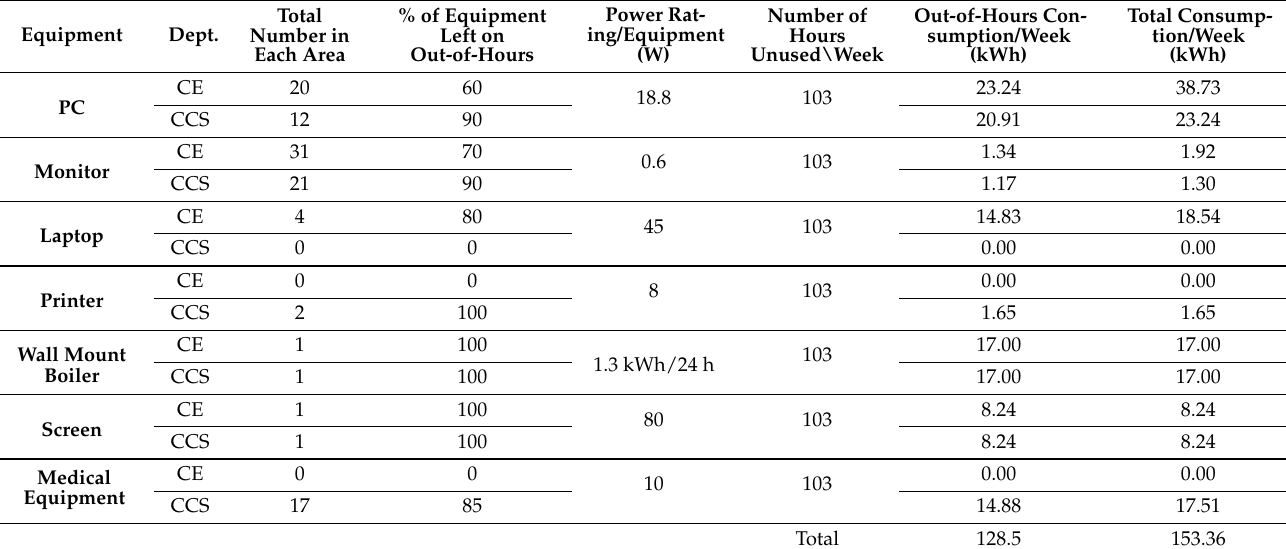
Table 1. Electricity waste due to equipment left switched on outside of working